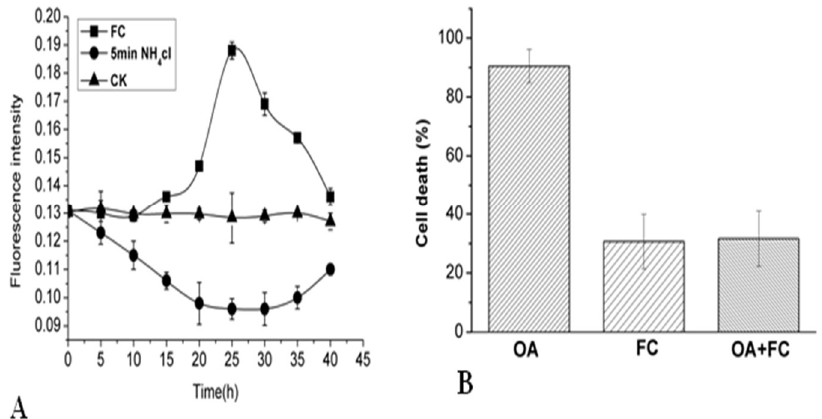
Figure 5. Effects of different agents on pH cyt and related changes in cell viability. Effects of FC and NH 4 Cl on the pH cyt ( A ). Effects of FC on the 1 mM OA-treated cell viability ( B ). Values are expressed as means ± SEM; p < 0.05.